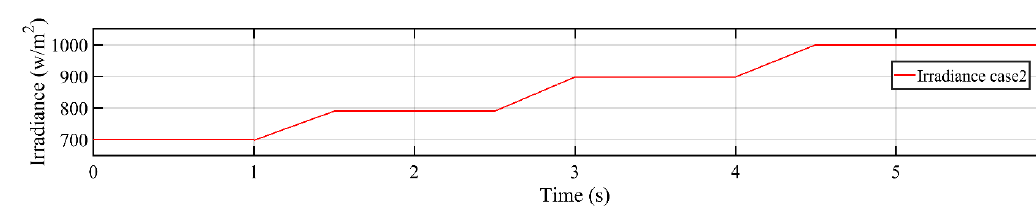
Figure 11. Case 1, fast-changing irradiance.